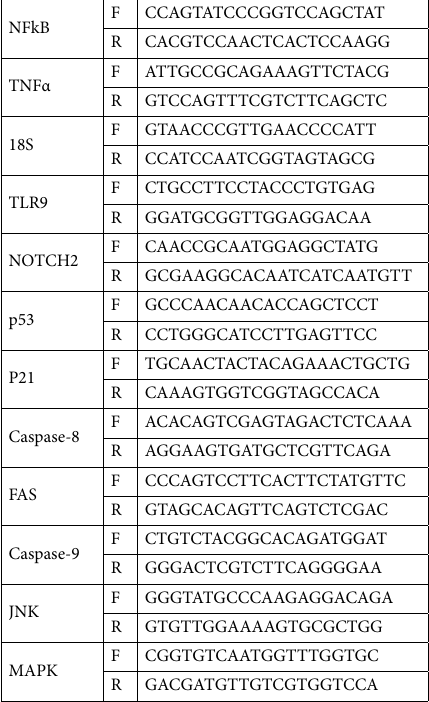
Table 1. List of